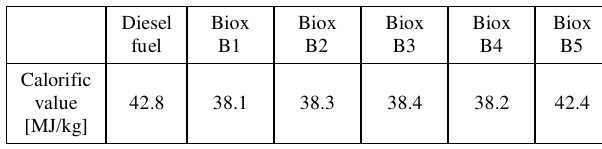
Fig. 3. Example of the positive part of the cyclodynes obtained during the engine test with the fuels with different properties [7] with centres of gravity marked with dots Table 6. Calorific values of the samples, which testing results are present- ed in Fig.